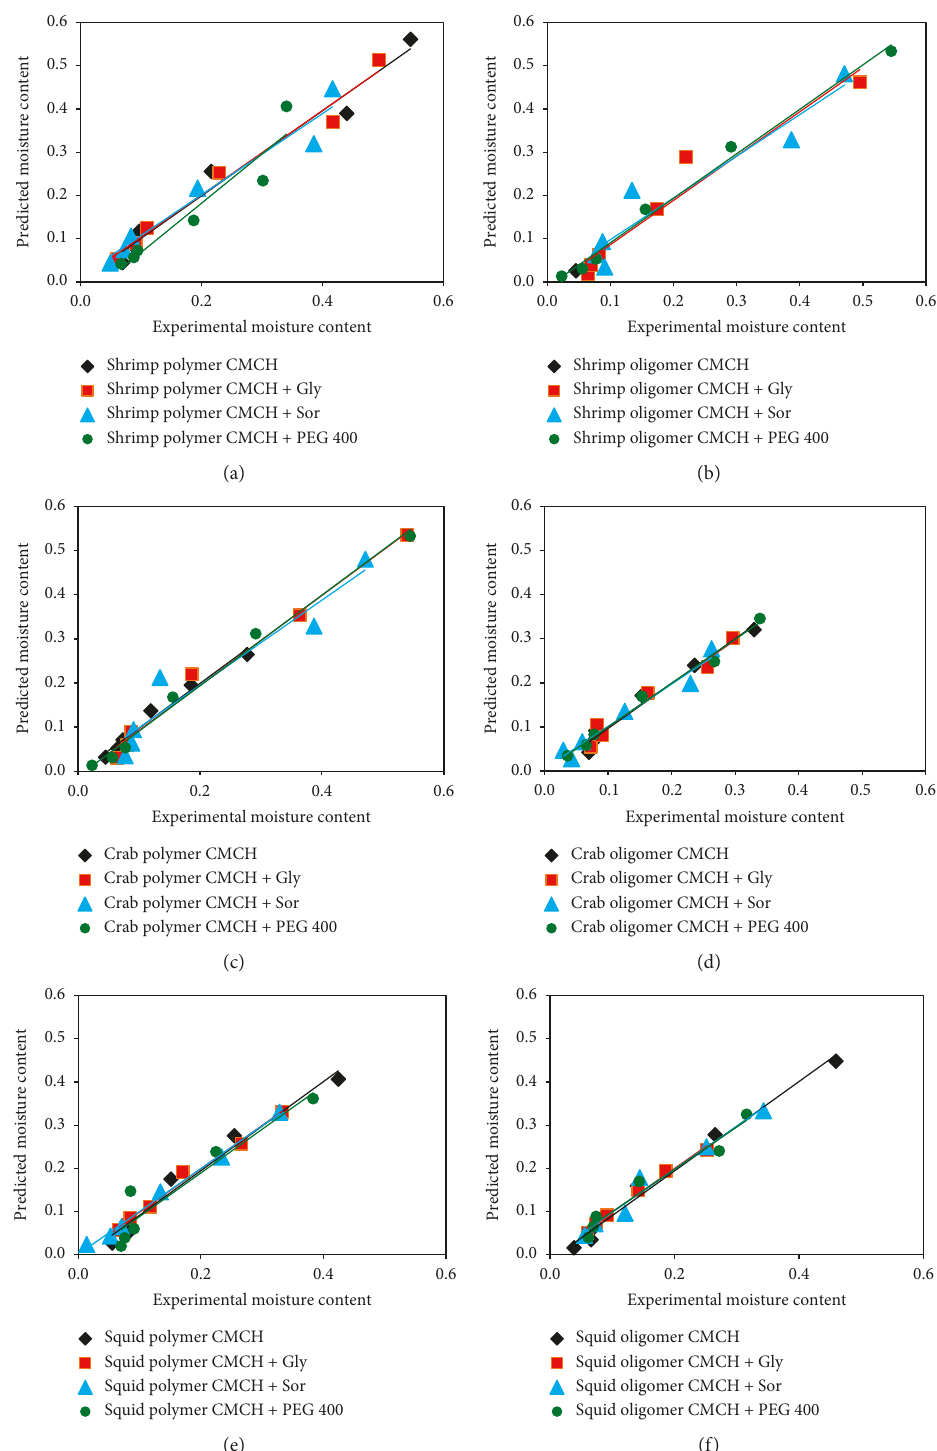
Figure 9: The comparison between the experimental moisture content values and those predicted for all the CMCH films from the Henderson model: shrimp polymer CMCH films (a); shrimp oligomer CMCH films (b); crab polymer CMCH films (c); crab oligomer CMCH films (d); squid polymer CMCH films (e); squid oligomer CMCH films